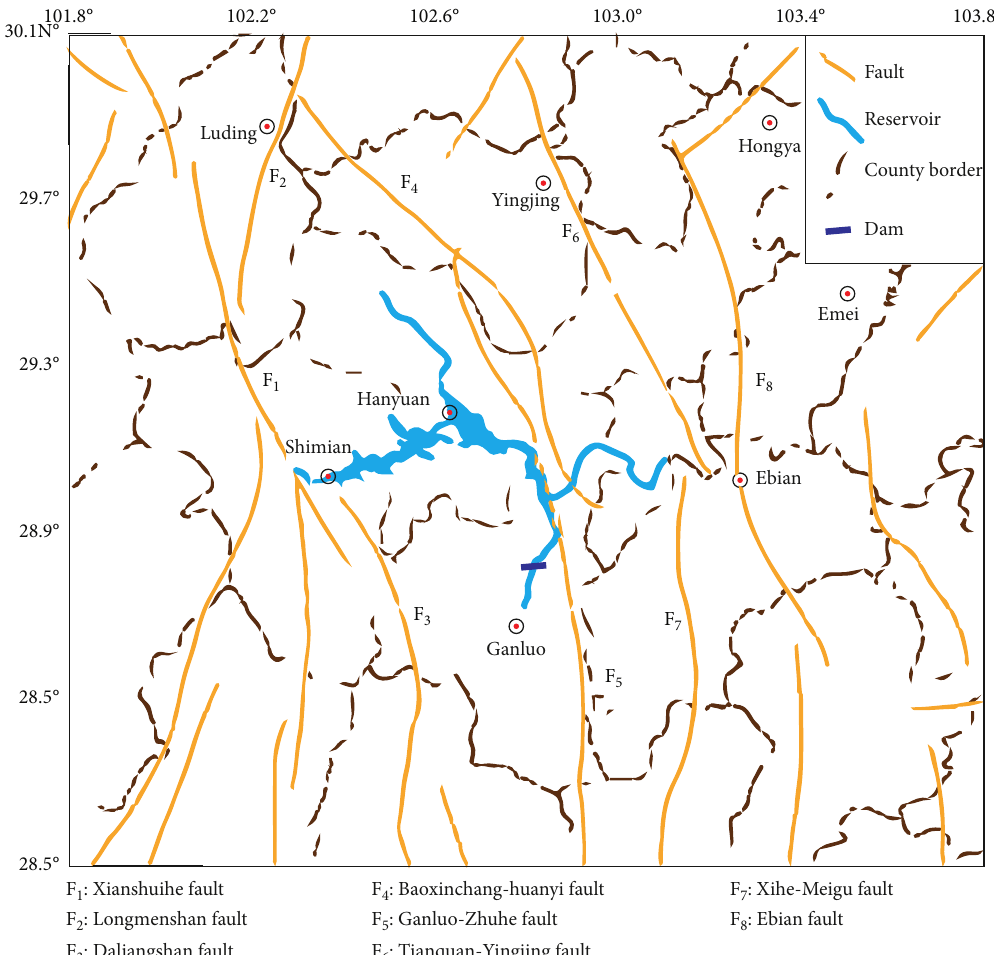
Figure 4: Large-scale faults around the PBG hydropower